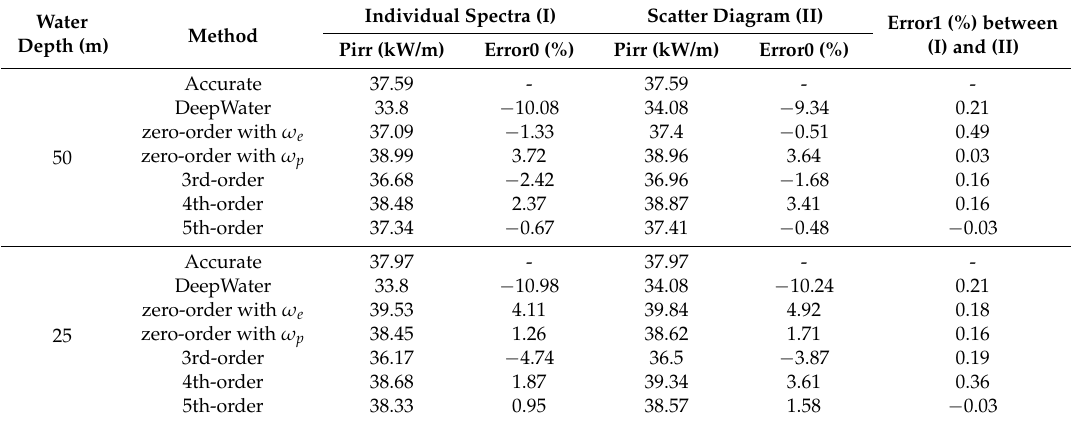
Table 3. Wave power assessment for AMETS (bin size: 0.5 m & 0.5 s).